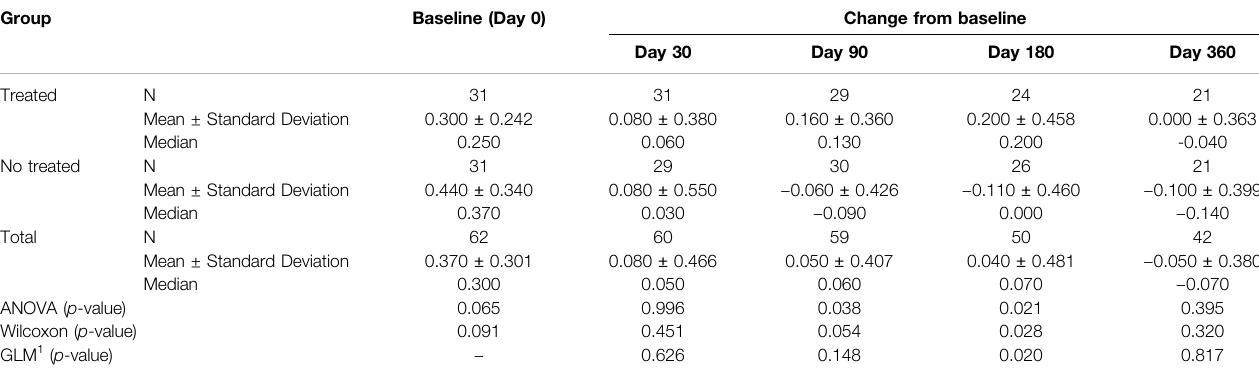
TABLE4D| (part4of5).GAITparameterscohortwithoutoutliers.PeakKneeFlex-Extension.GeneralLinearModelwithPeakKneeFlex-Extensionchangefrombaselineas dependent variable, treatment as factor, and Peak Knee Flex-Extension baseline value as covariate. Group